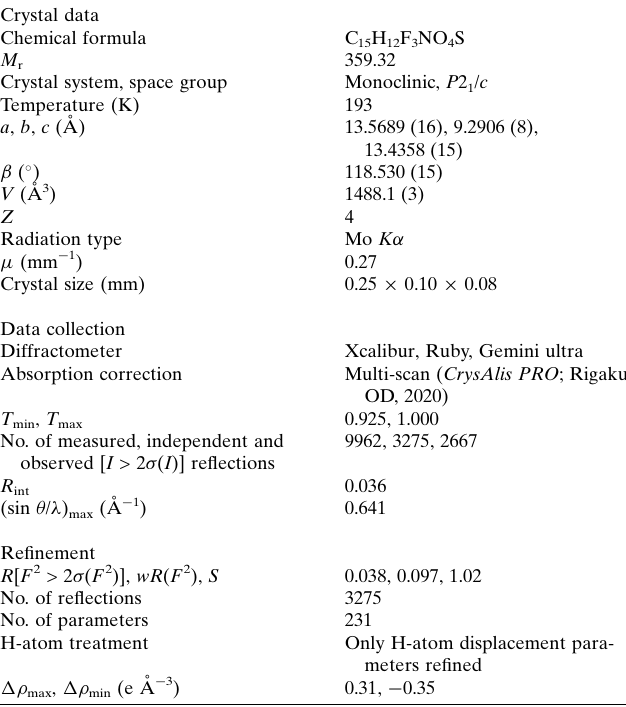
Crystal data Chemical